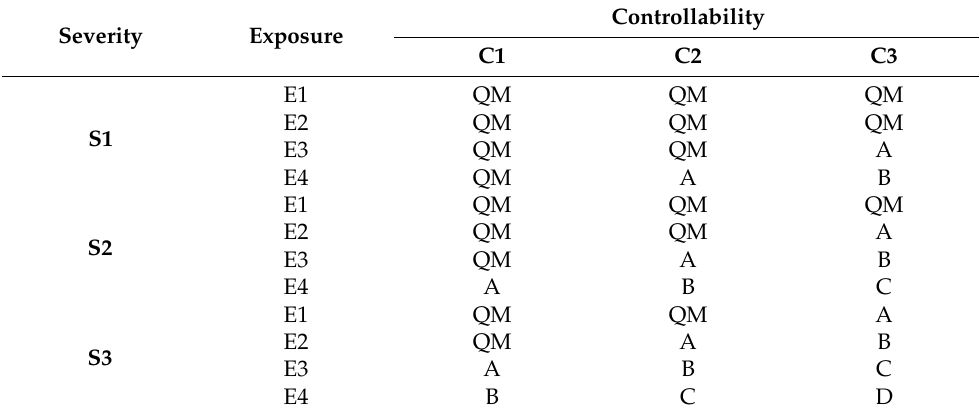
Table 1. Risk graph matrix of the